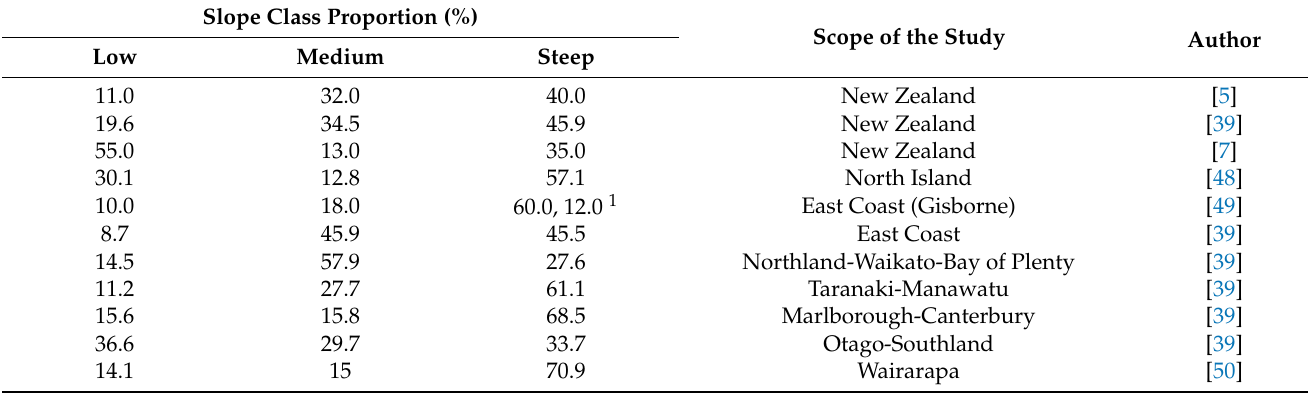
Proportion of the hill country marked with 1 superscript are classified as extreme slope (near